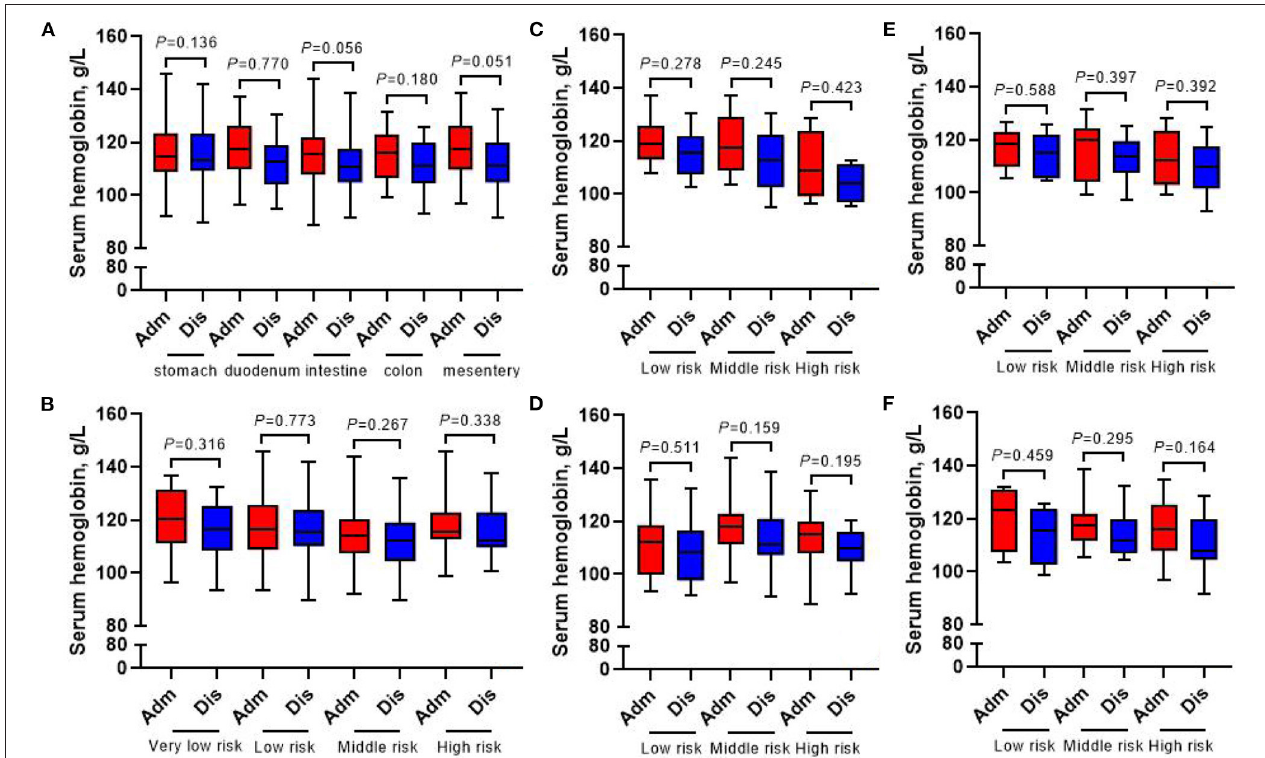
FIGURE 7 | Changes of serum hemoglobin in 413 GIST patients at admission and discharge. (A) Total; (B) stomach; (C) duodenum; (D) intestine; (E) colorectal; (F) mesentery.